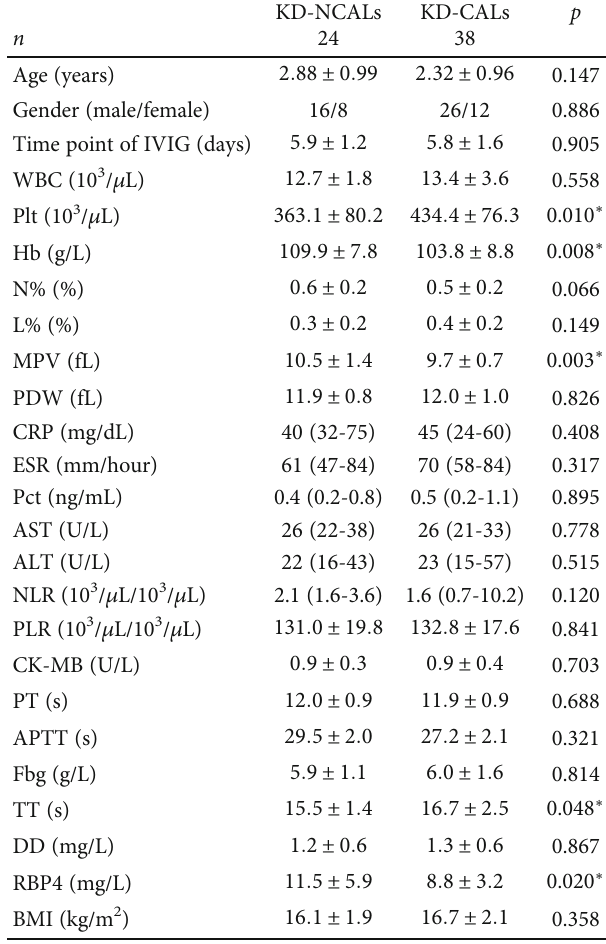
Table 1: Basic characteristics of all KD